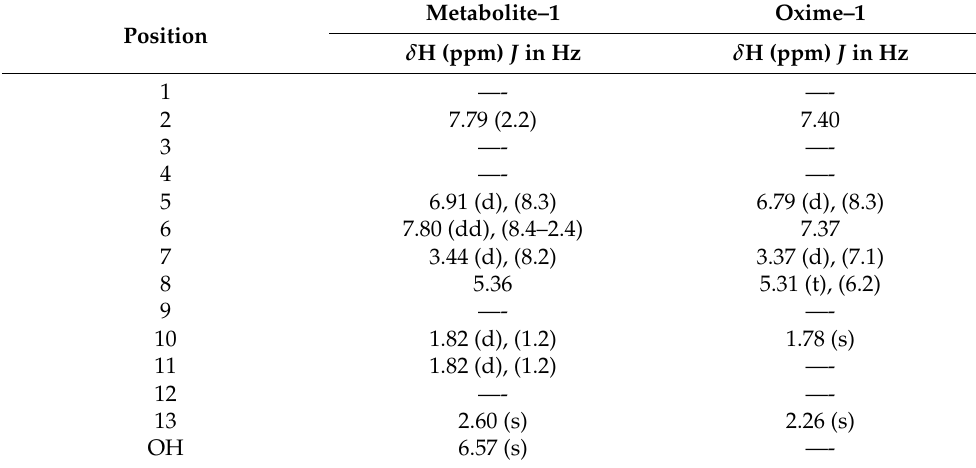
Table 1. 1 H NMR spectroscopic data of metabolite–1 and respective oxime–1 (in CDCl 3 at 400 MHz).